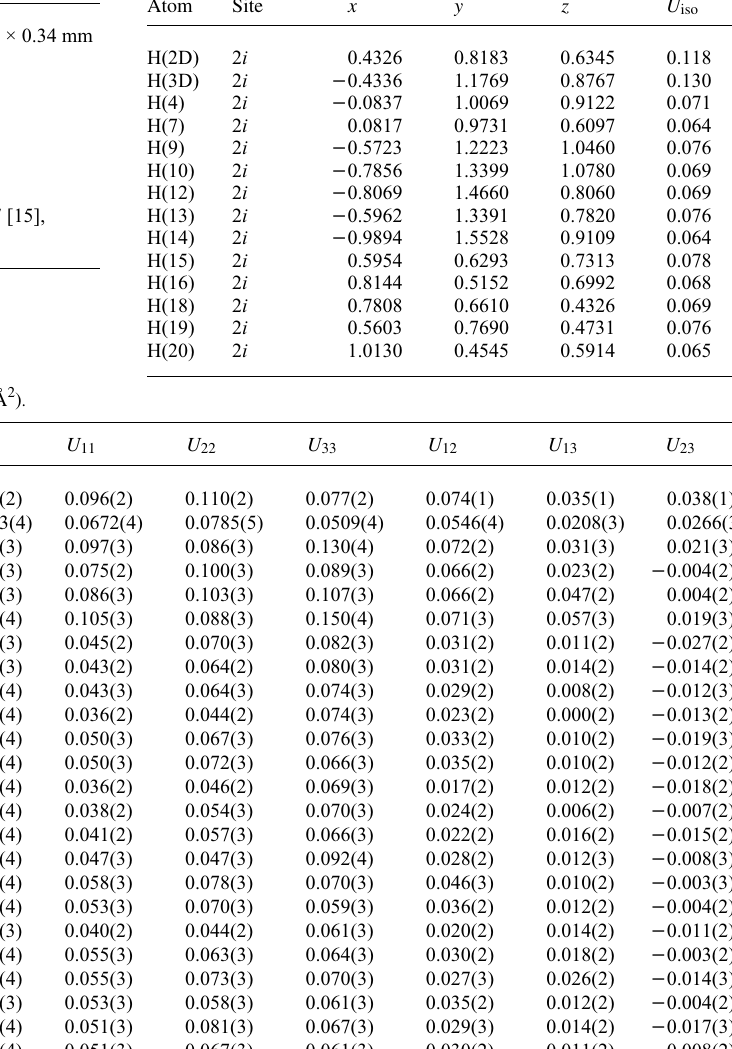
Table 1. Data collection and